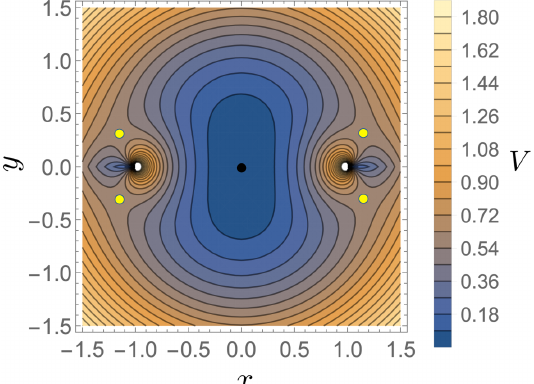
FIG. 2. Contours of the nonlinear potential (10) for a typical insert strength τ ¼ − 0 . 4 . Singularities occur at the points ð x; y Þ ¼ ð(cid:4) 1 ; 0 Þ . The potential is continuous away from these points and real-analytic away from the branch cuts ( j x j ≥ 1 , y ¼ 0 ). Symmetry exists under reflections x ↦ − x and y ↦ − y . Note the presence of one minimum (black dot) and 4 saddle points (yellow